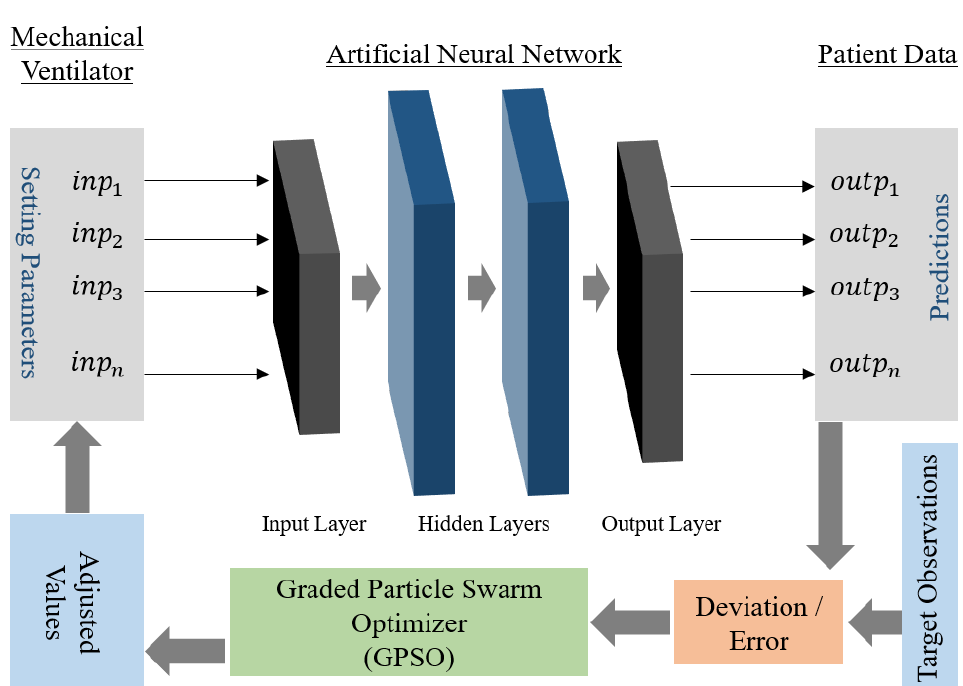
Figure 1. An outline of IANN for tuning mechanical ventilator parameters based on true observations. The mechanical ventilator inputs are, in the true sense, the outputs of the IANN. The GPSO in the loop compares the true observations with the predictions obtained from the ANN and makes adjustments to the inputs